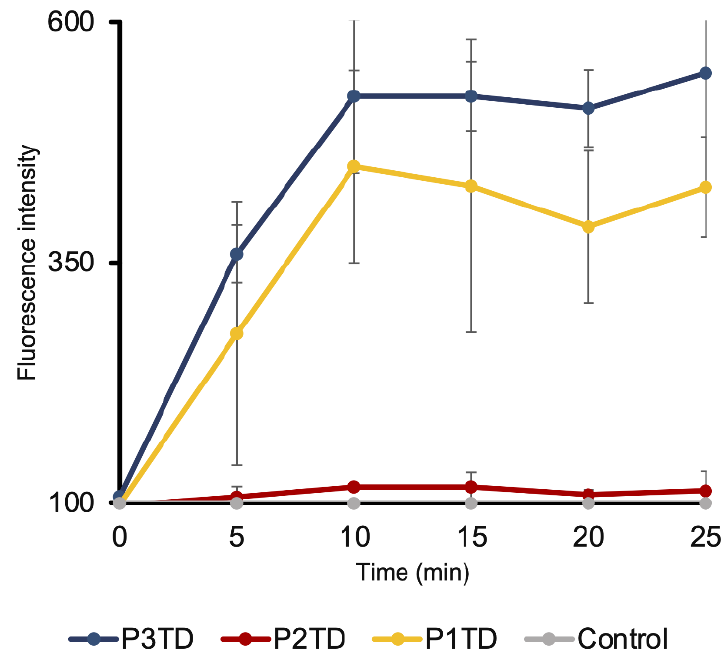
Figure 9. Cell membrane depolarization of E. coli by cationic polymers P1TD, P2TD and P3TD measured by the increase in DiSC 3 (5) fluorescence. Standard deviation is plotted with error bars in the graph. Polymer concentration was 0.5 mg/mL.